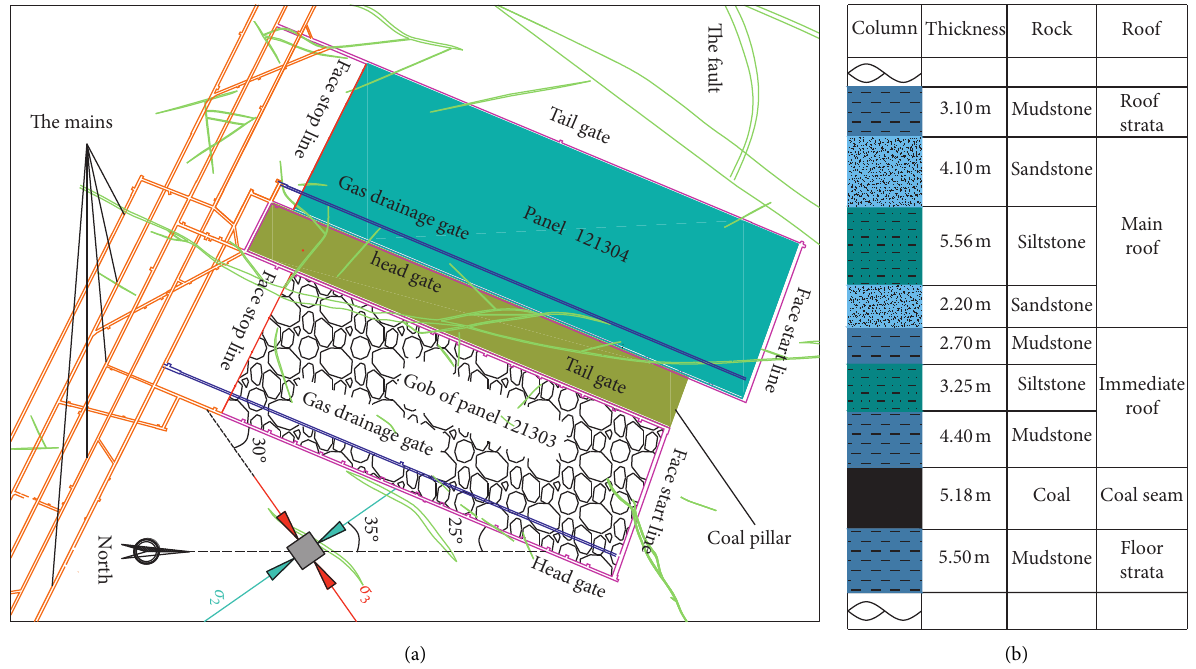
Figure 1: Mining conditions. (a) Plane view of the panel. (b) Geological